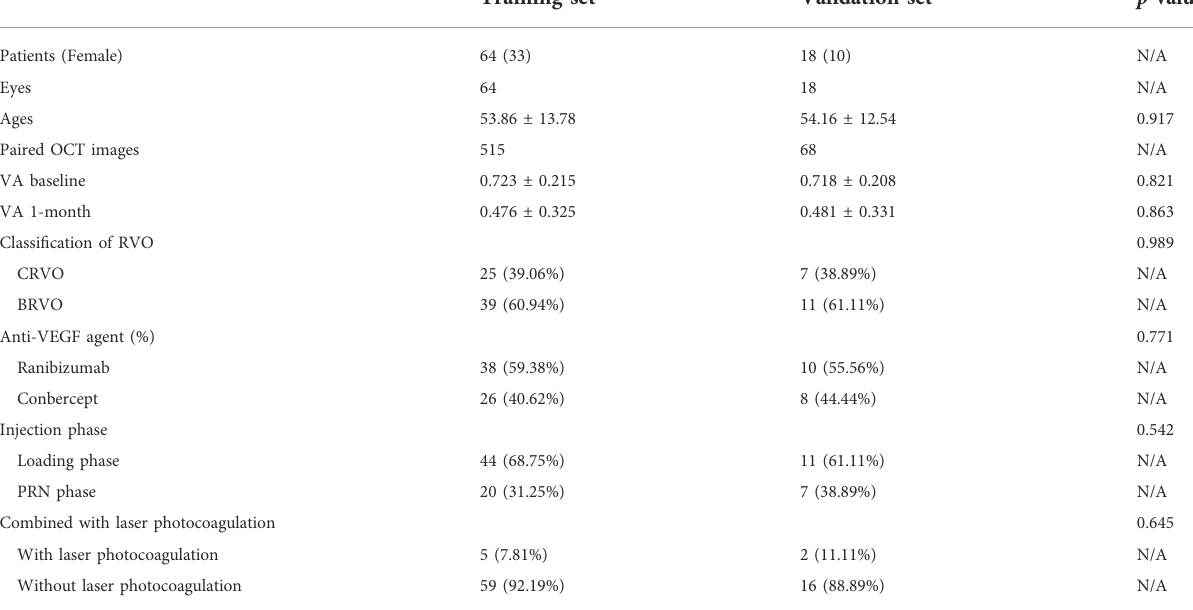
TABLE 1 Patient